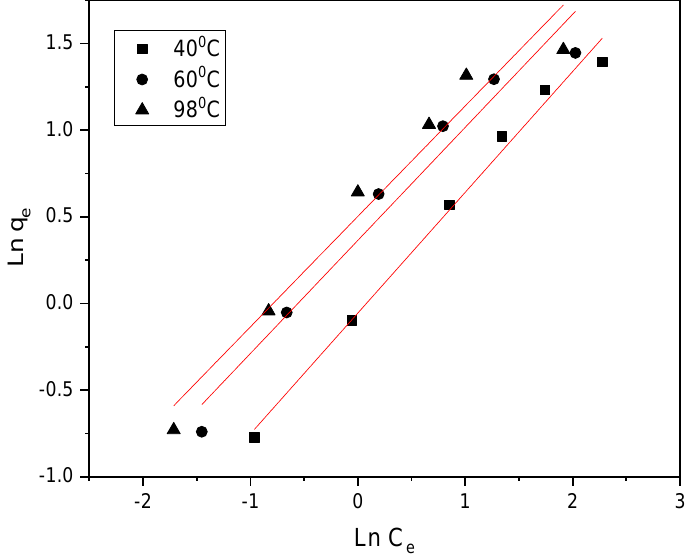
Figure 3. Graphic representation of a linear Freundlich model for dyeing polyamide 6.6 fabric at different